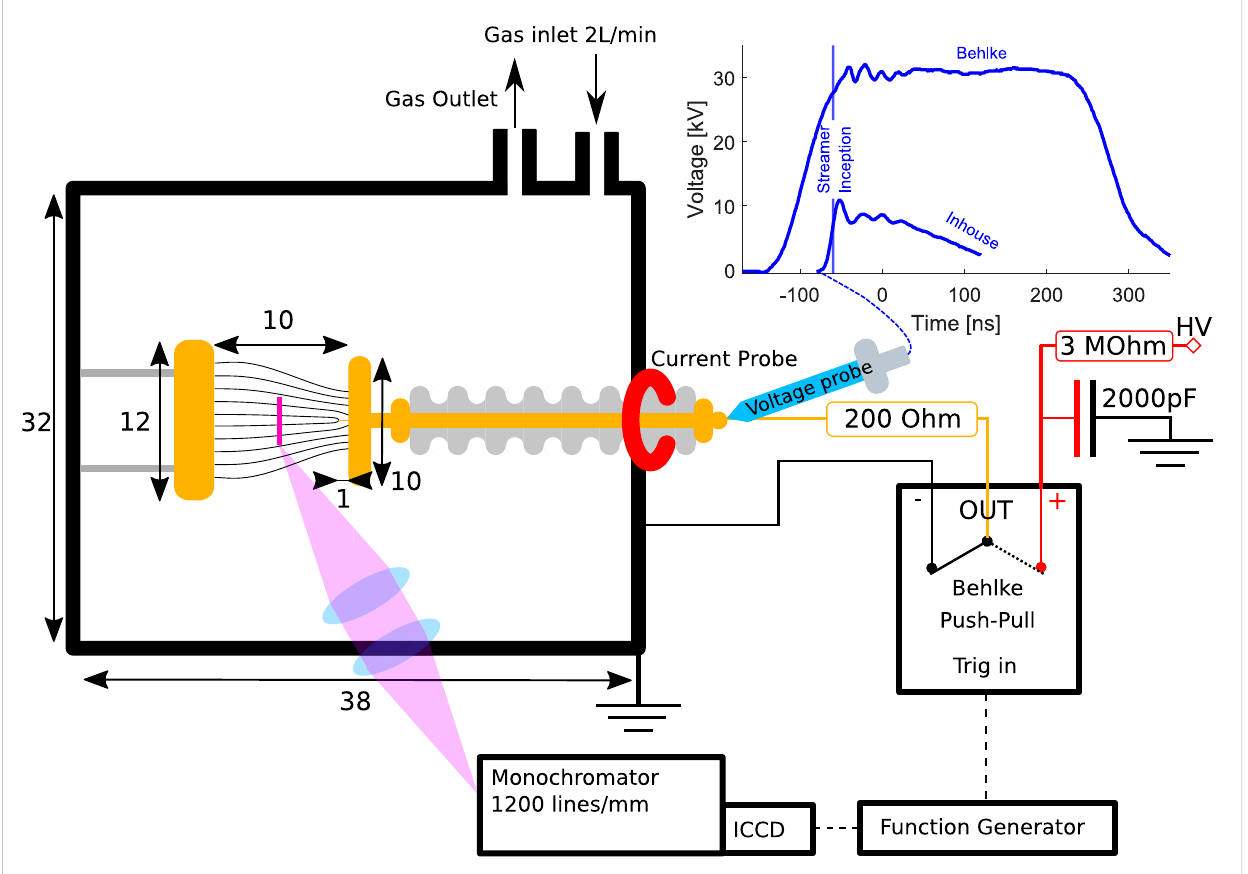
FIGURE 3 Schematic overview of setup, with dimensions in centimeters. Between the opposing disk electrodes calculated electrostatic fi eld lines of the fi eld before streamer inception are drawn. The total propagation length of the streamer is 9 cm (10 cm between theopposing electrode disks minus the1 cm protruding needle length). The magenta bar shows the region which is imaged on the monochromator entrance slit. The voltage waveforms for the two pulsecircuitsareshown,andthetimeaxisissynchronizedtothe fi rststreamerlightcapturedatthecenterofthedischargegap;theactualamplitude and width are adjusted between experiments. Only one of the two circuits (the Behlke push-pull circuit) is